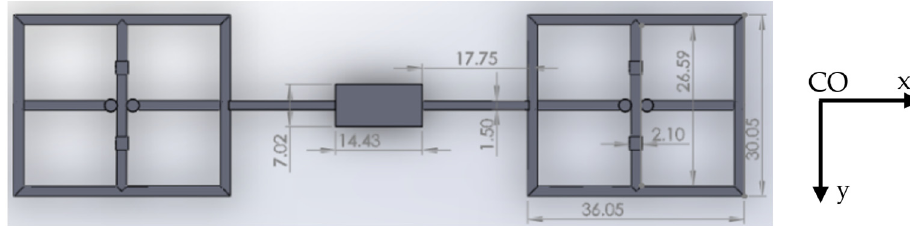
Figure 4. Plan view of the model (dimensions in cm) developed (developed with SolidWorks [60]).